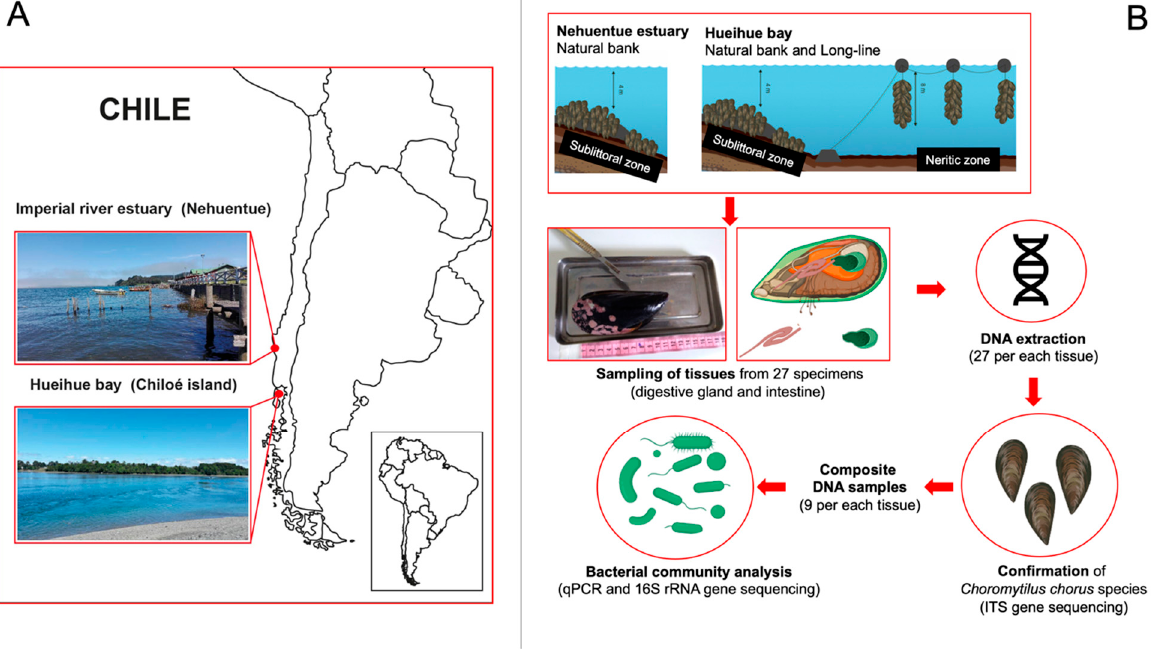
Figure 1. ( A ) Map showing the Nehuentue Estuary and Hueihue Bay, where specimens of Choromytilus chorus were collected from natural banks and from a long–line system, respectively. ( B ) Schematic of experimental design used in this study.